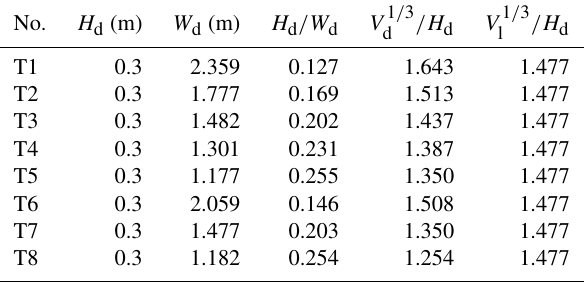
Figure 1. Gradation curve of the dam